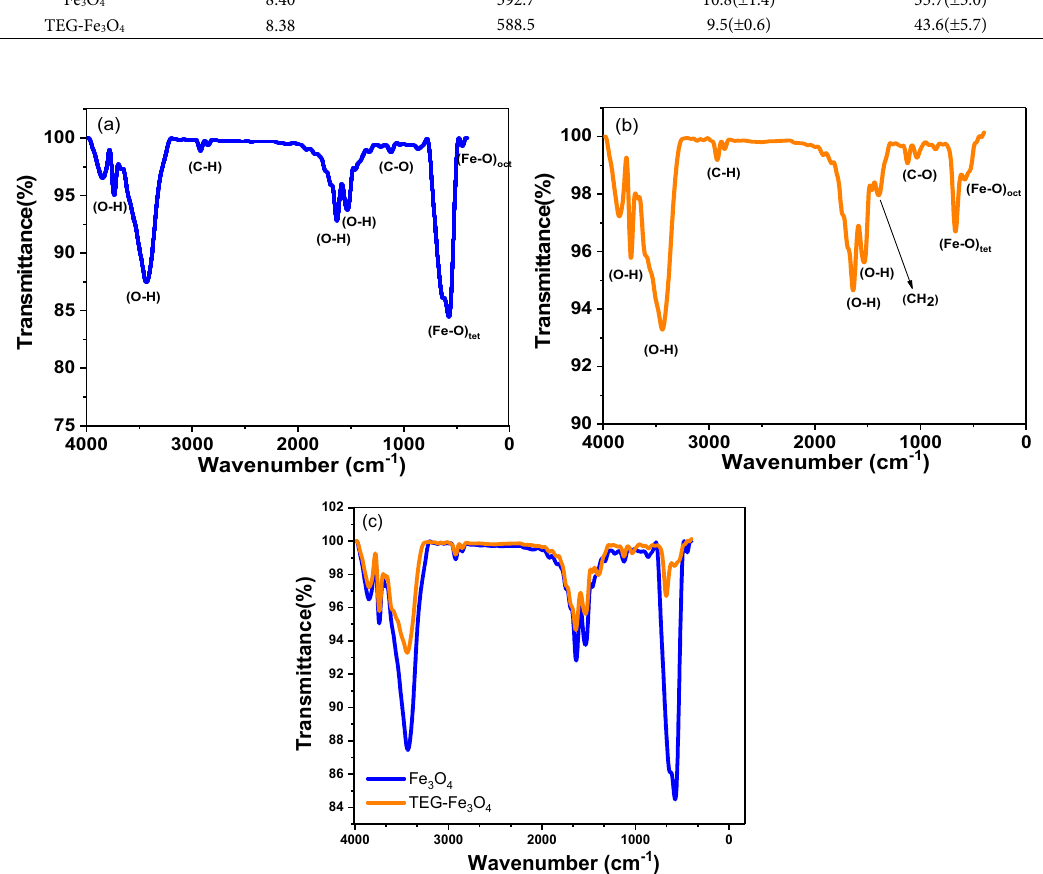
Fig. 2. FTIR spectra of (a) Fe